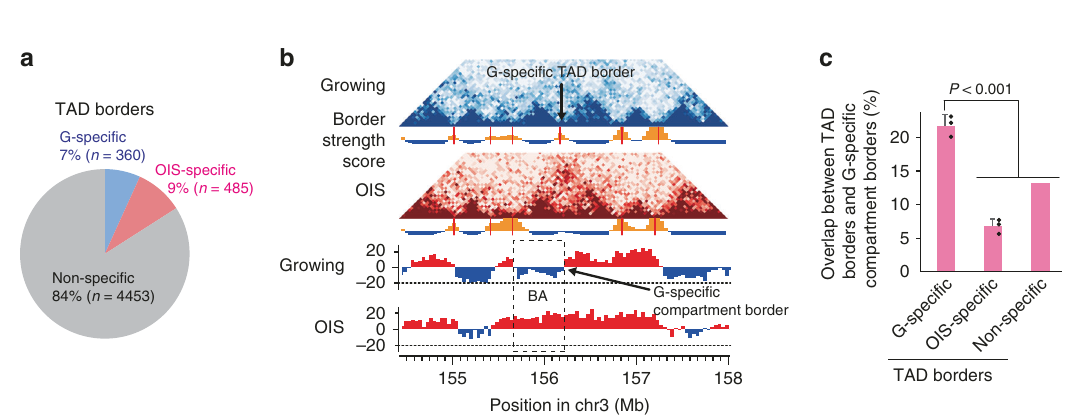
Fig. 4 Condensin is enriched at BA-switching regions in OIS cells. a GSEA of genes located at BA-switching regions. All human genes were ranked by expression fold changes (FC), calculated as expression levels of genes in OIS cells divided by those in growing cells (blue distribution). For this GSEA, the difference in PCA scores between OIS and growing cells was calculated for each BA-switching region, and the top 300 genes present at the regions with the largest difference in PCA scores were analyzed. NES, normalized enrichment score. b GSEA of genes located at AB-switching regions ( n = 263). c ChIP- seq enrichment of the indicated proteins and epigenetic marks for the respective compartmental categories in growing (G) and OIS cells. Five hundred genomic regions (40 kb bins) were randomly sampled from each compartmental category, and distributions of average ChIP enrichments are shown as boxplots (central bar represents the median with boxes indicating the upper and lower quartiles, and whiskers extend to the data points, which are no more than 1.5× the interquartile range from the box; outliers shown as circles). ChIP-seq data for the epigenetic marks and LMNB1 were previously published 47,70 . d An example of how BA transitions of small B compartments change the compartmental organization upon OIS. PCA scores in growing and OIS cells are plotted along a 50 Mb region in chromosome 4. BA transitions upon OIS are indicated by arrows. ChIP-seq data for CAP-H2, H3K4me3, H3K9me3, and LMNB1 are shown beneath. e Same as panel d , but a 5 Mb region with a single BA transition (dotted) is shown. f GO analysis of the 96 genes that are present at BA-switching regions and signi fi cantly upregulated upon OIS. These genes were cross-referenced with genes involved in speci fi c biological processes to test the signi fi cance of their overlap (Fisher exact test).